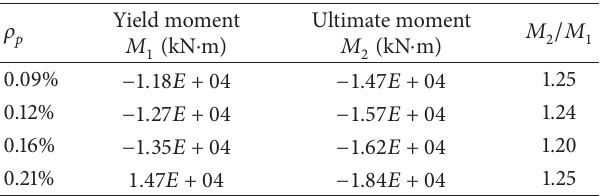
Figure 6: 𝑀 − 𝜑 curve of bottom section of PRC pier with different longitudinal reinforcement ratios. Table 2: Calculation results of PRC bridge piers with different prestressed tendon